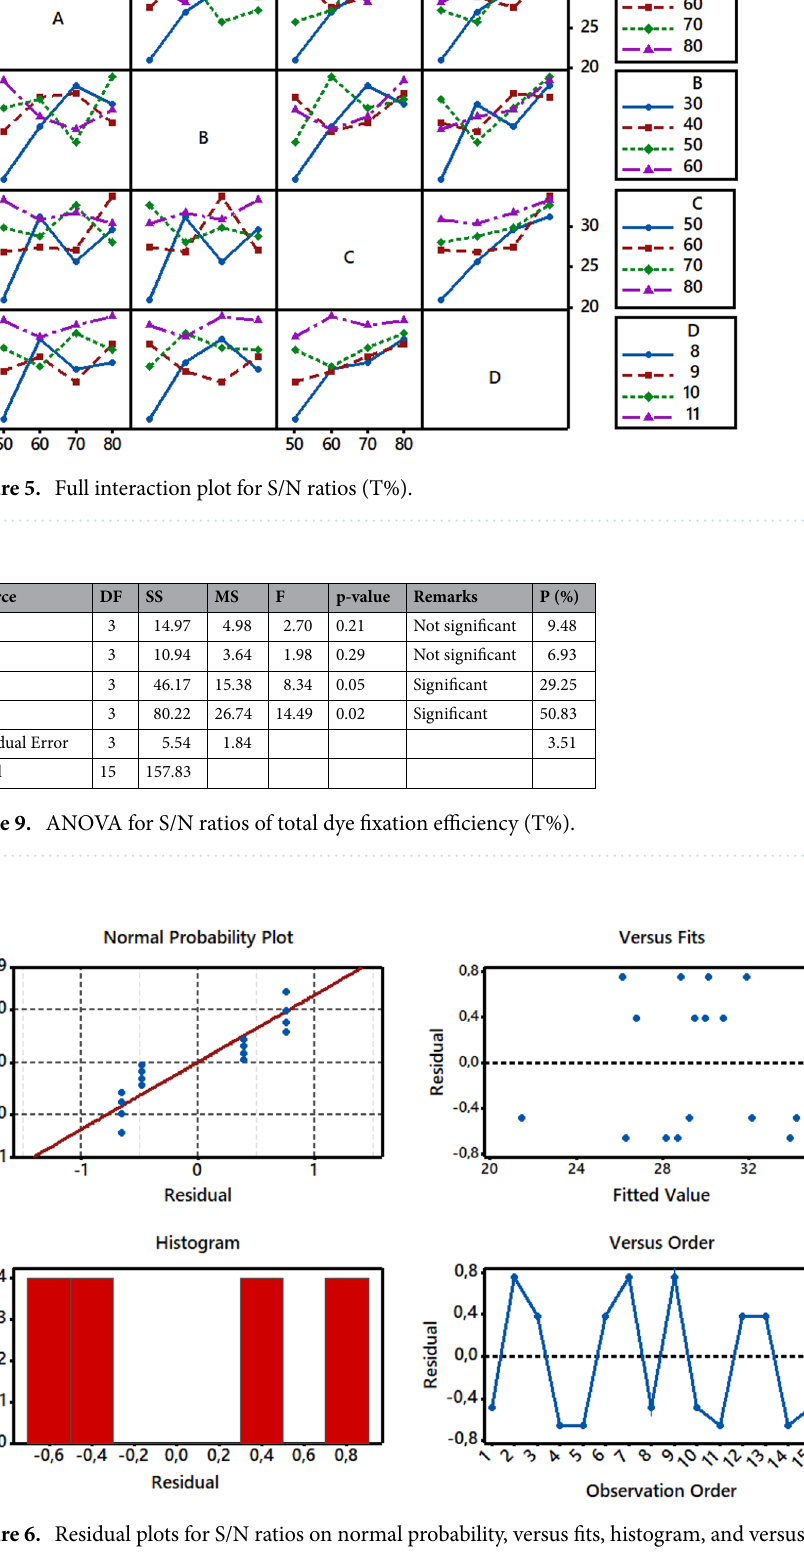
Figure 6. Residual plots for S/N ratios on normal probability, versus fits, histogram, and versus